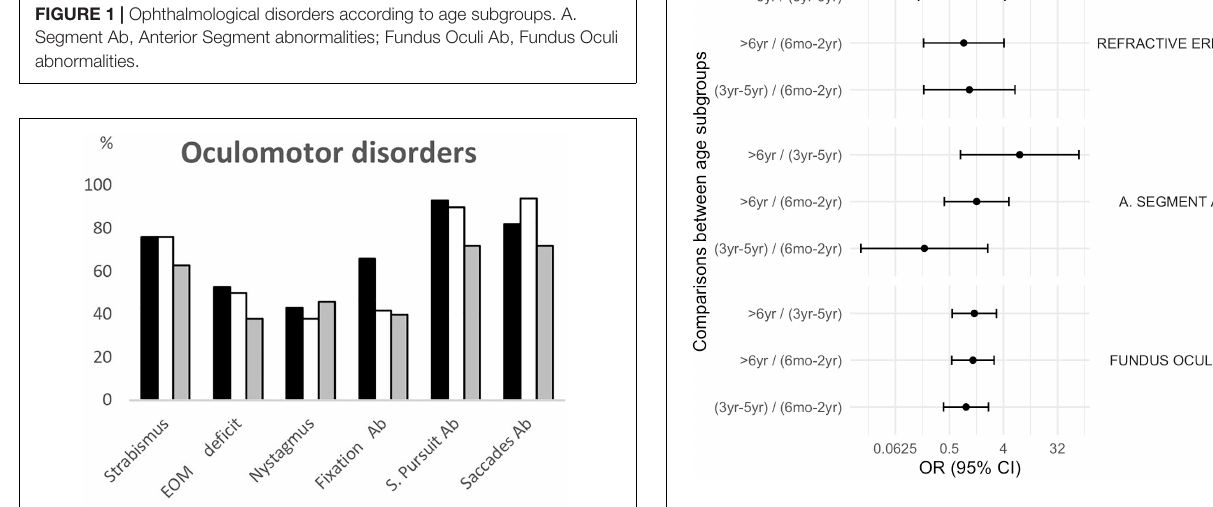
FIGURE 4 | Comparison between subgroups, OR (CI 95%): ophthalmological disorders. A. Segment Ab, Anterior Segment abnormalities; Fundus Oculi Ab, Fundus Oculi abnormalities.